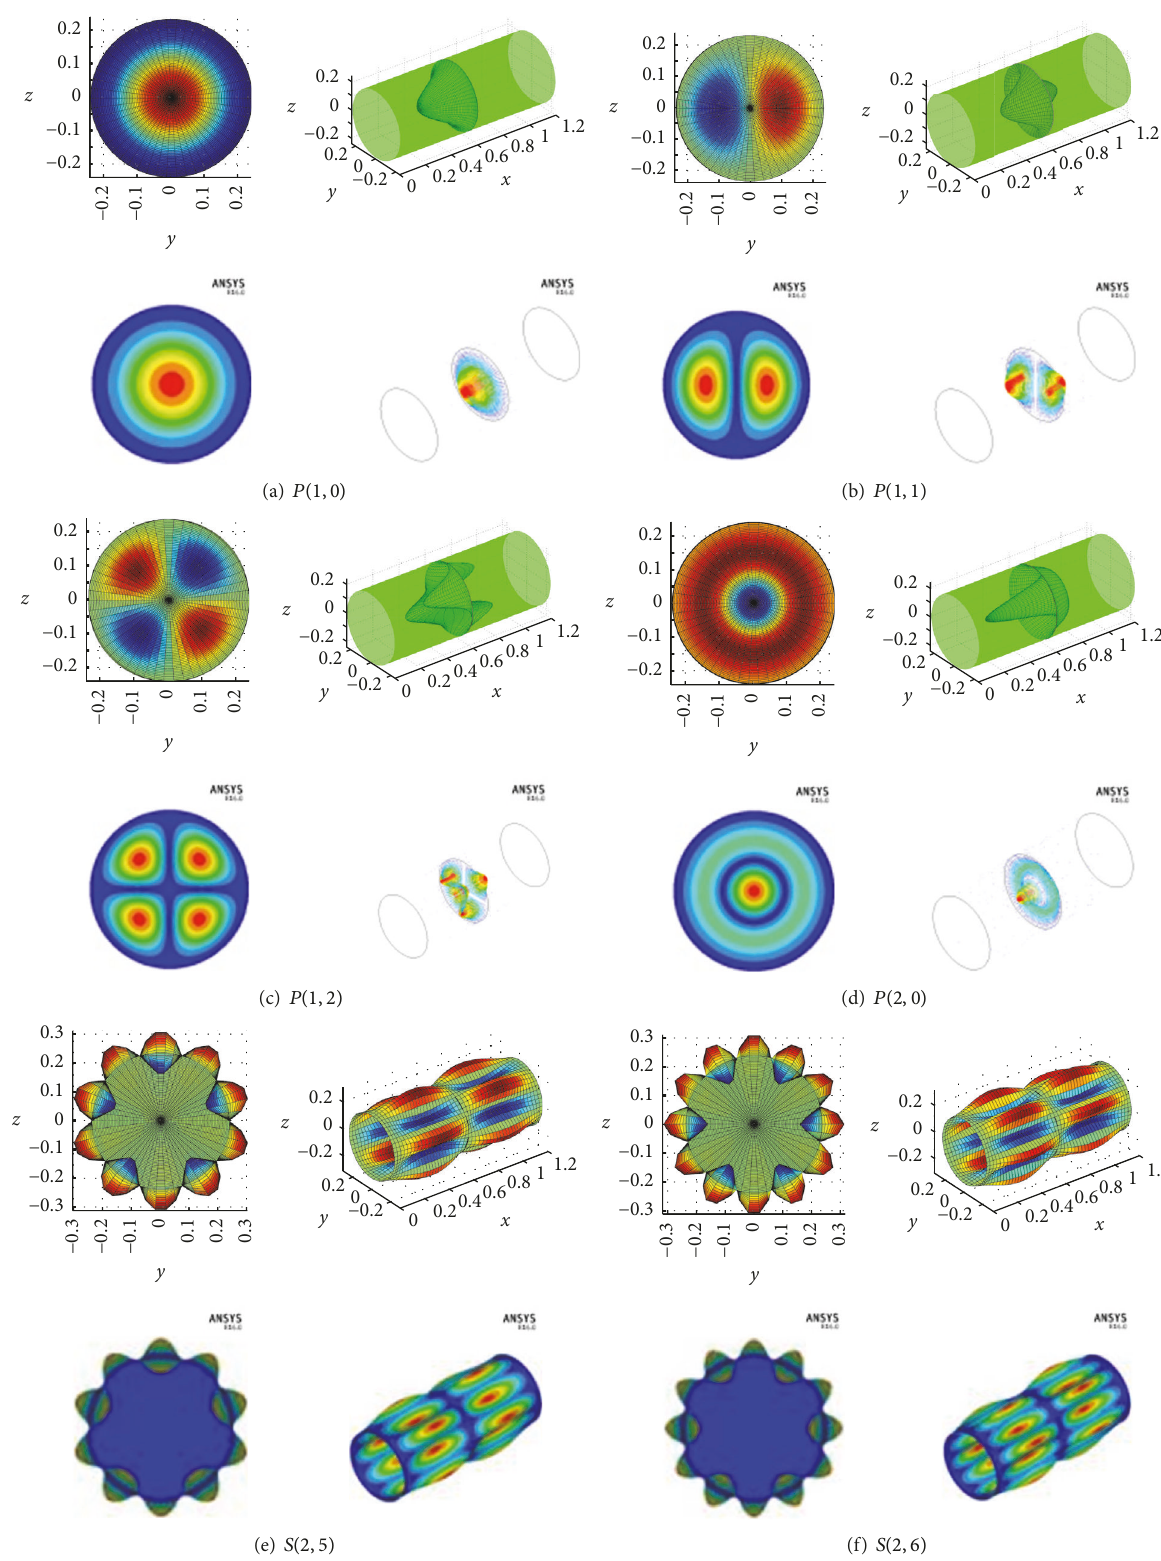
Figure 4: The modes of coupled structures with